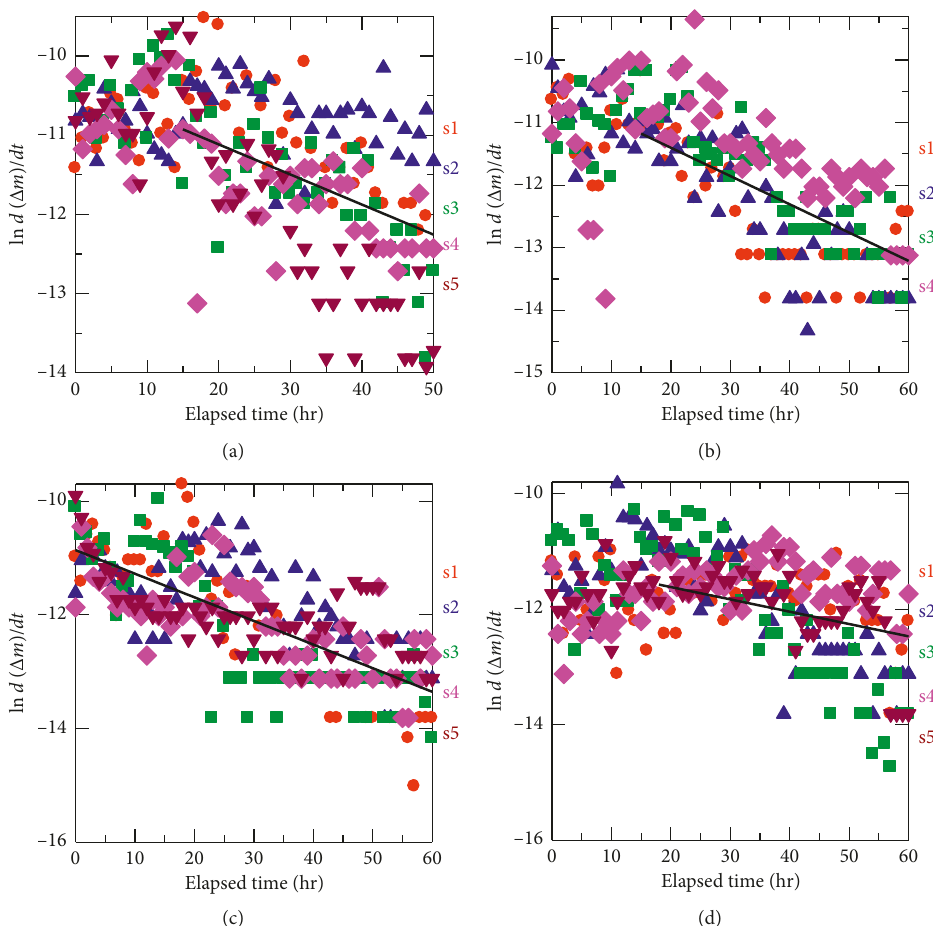
Figure 14: Mass change of specimens as a function of elapsed time. The thick black line gives the regression line to calculate average diffusion coefficient. (a) Mchenga arkose sandstone. (b) Mchenga fine-grained sandstone. (c) Kaziwiziwi conglomerate. (d) Kaziwiziwi carbonaceous sandstone.